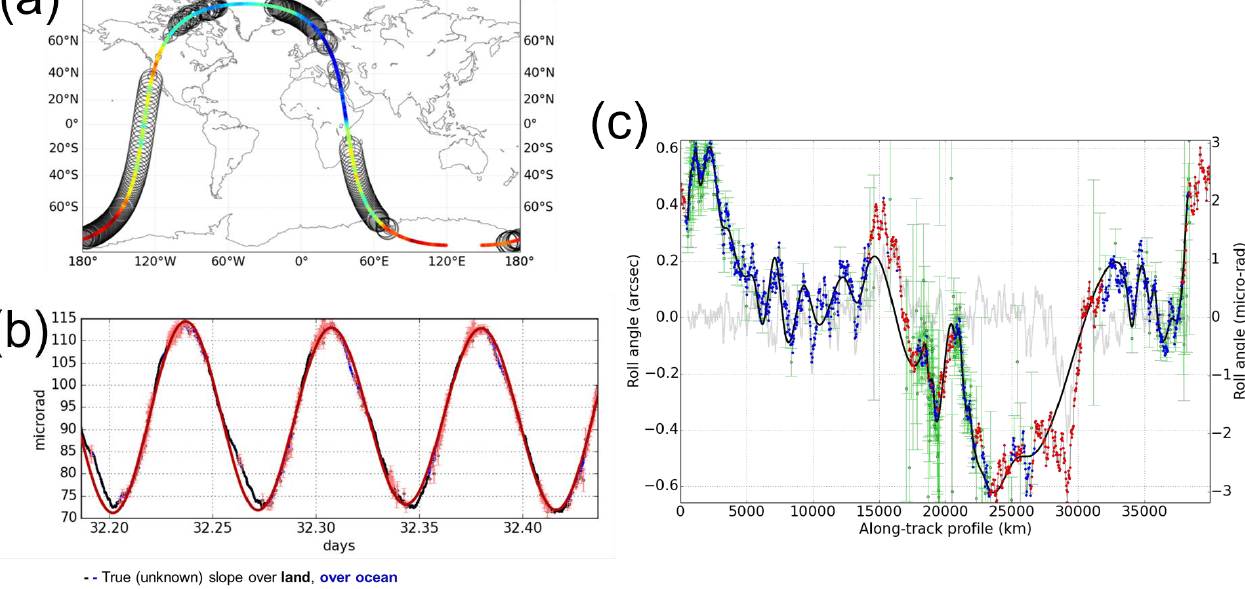
Figure 11. Interpolation of local crossover calibrations into a global correction. Panel ( a ) shows the location of each crossover diamond (circles). Panel ( b ) is the orbital harmonic interpolator (adjustment of sine functions with a frequency that is a multiple of the orbital revolution period) used on the local crossover estimates (pink dots + vertical error bar) to retrieve the uncalibrated error (black for inland segments, blue for ocean segments). Panel ( c ) shows the final kernel-based interpolation for the broadband (non-harmonic) signals. The local crossover estimates are the green dots (with vertical error bars). The interpolated value is the black line. The thin grey line is the residual error (difference between the red/blue dots and the black